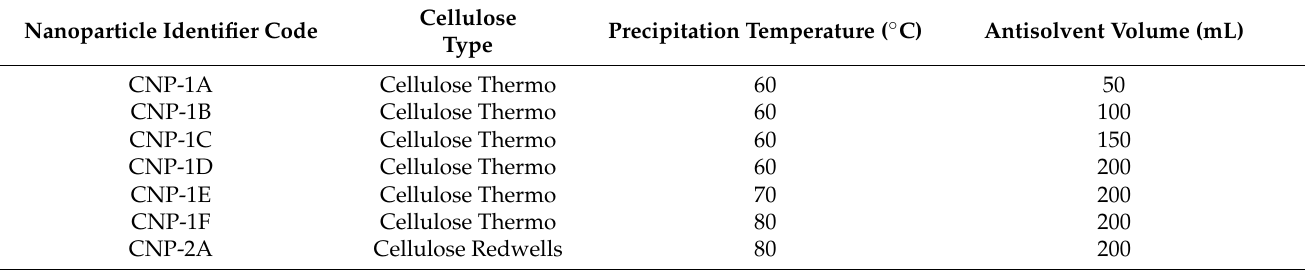
Table 1. Codes for the procedures